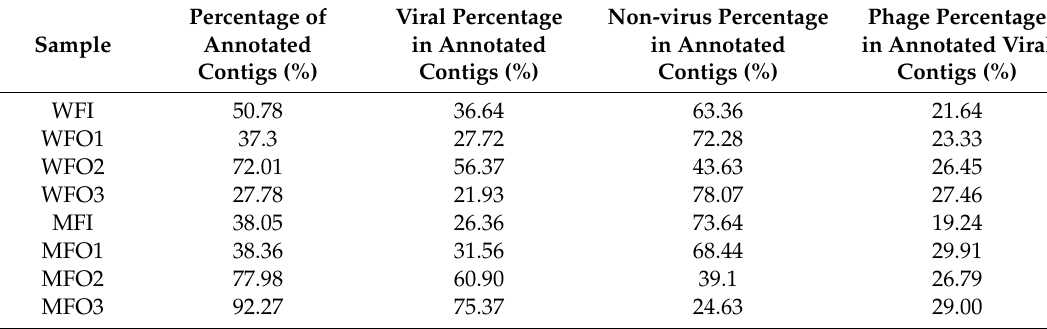
Table 2. Percentage of viral contigs, non-viral contigs, phage contigs resulting from sequencing reads of viromes from